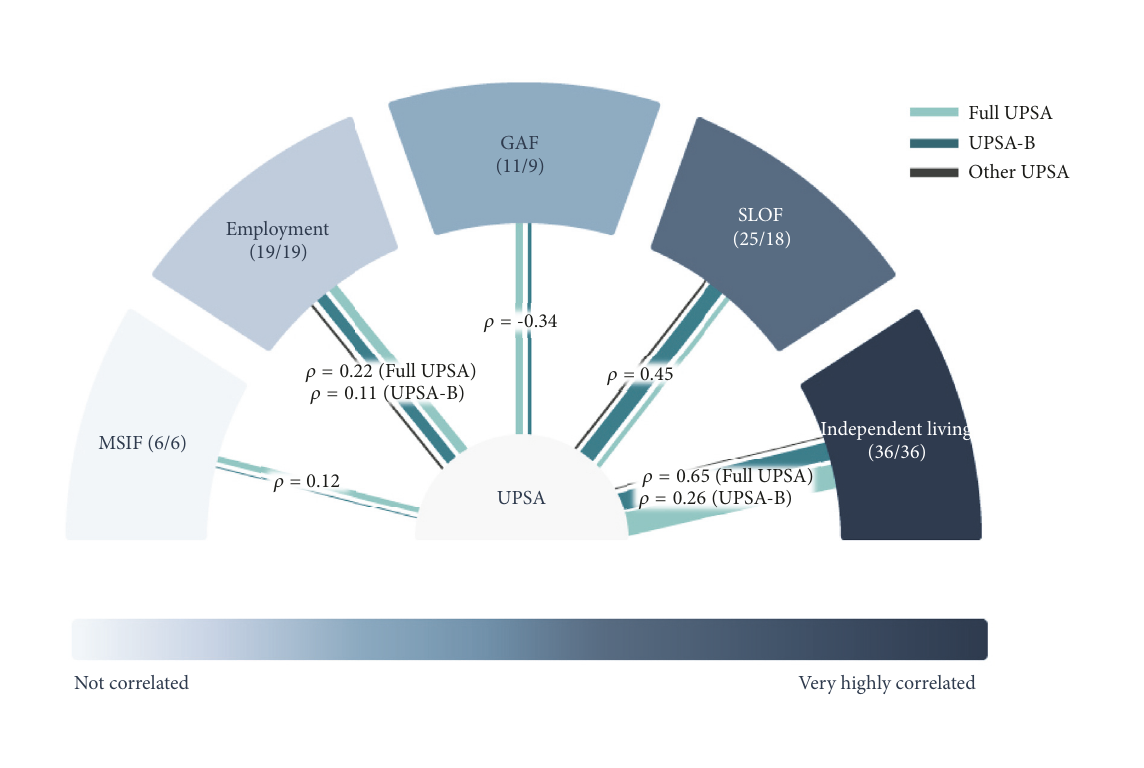
Figure 4: Th e stren g t h of correlations between U PS A and em p lo y ment status, residential status, t h e SLOF , MSIF , and G A F. Strength of correlations indicated by a correlation coefficient (according to UPSA type, if sufficient data are available) and color. The number of studies contributing evidence to a particular relationship is indicated by the thickness of the line connecting the UPSA to each of the other